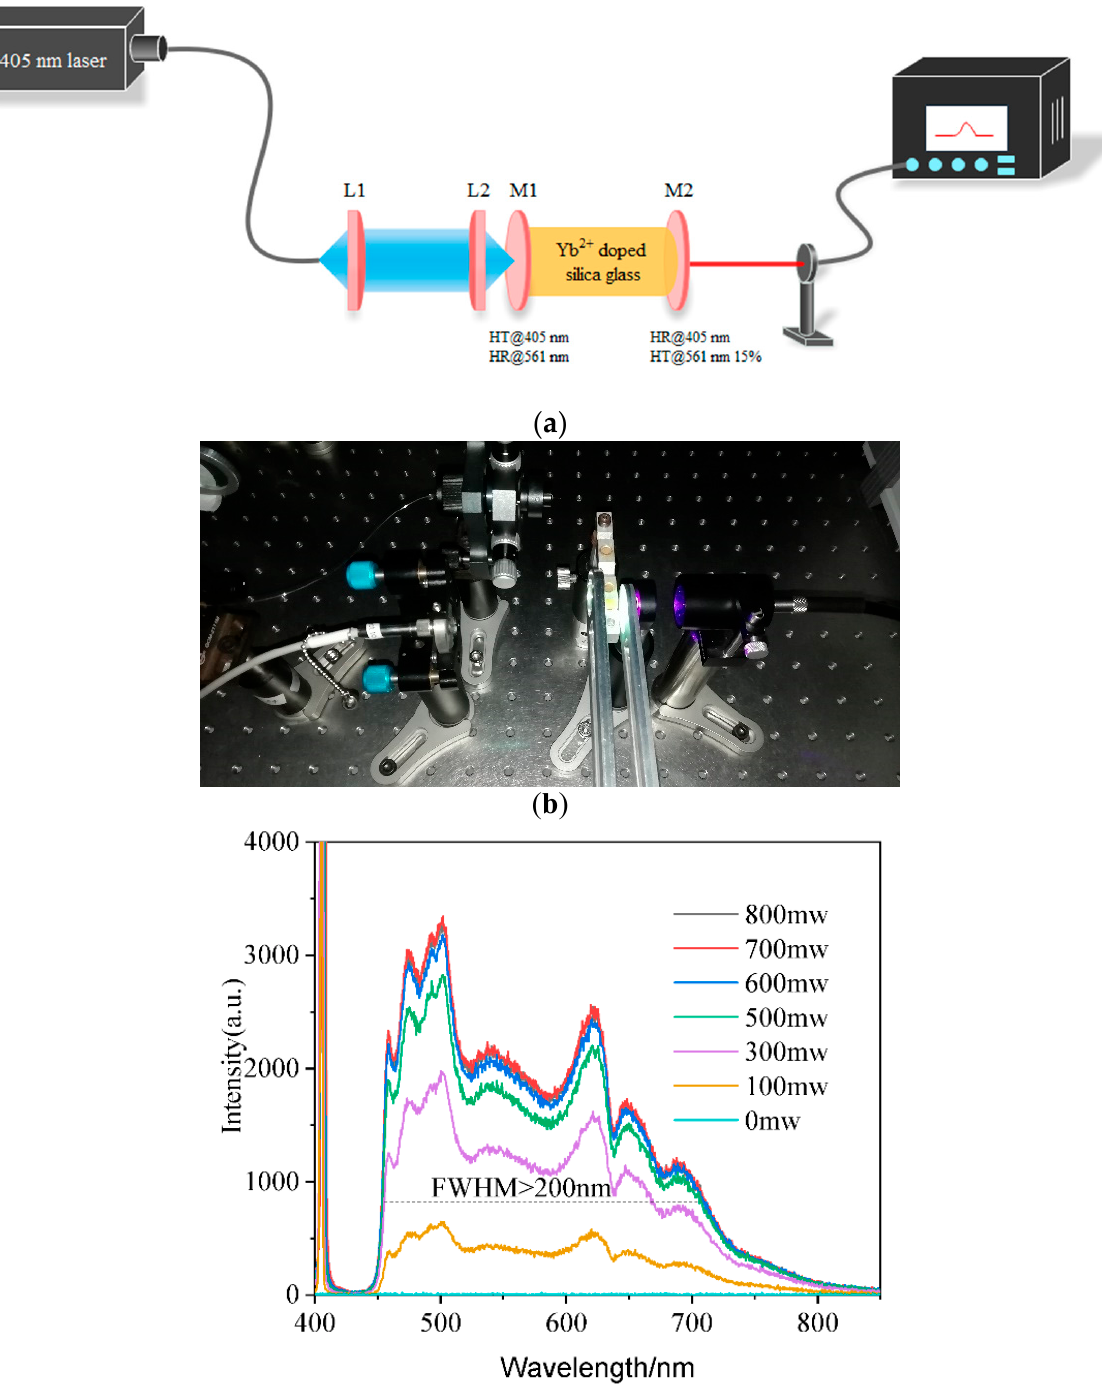
Figure 5. ( a ) Scheme of Yb 2+ -doped glass laser; ( b ) a simple glass solid laser cavity with Yb 2+ glass and ( c ) super-broadband fluorescence of Yb 2+ -doped glass in the F–P cavity using a 405 nm laser pump.